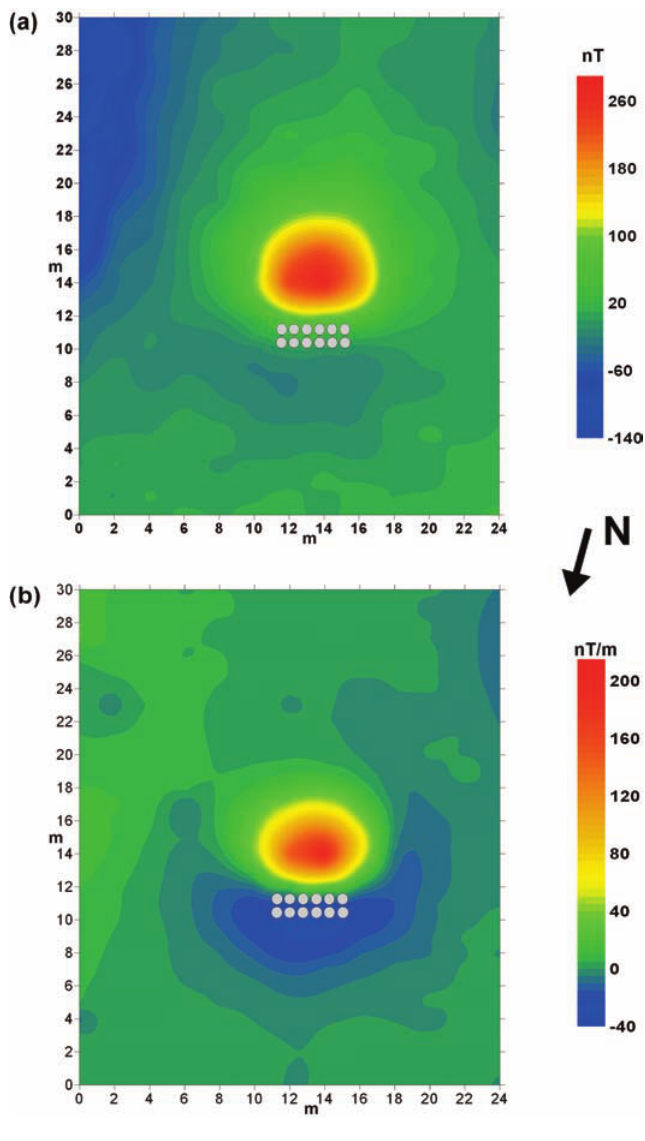
Figure 2. Magnetic anomaly maps of the total intensity field (a) and the vertical magnetic gradient